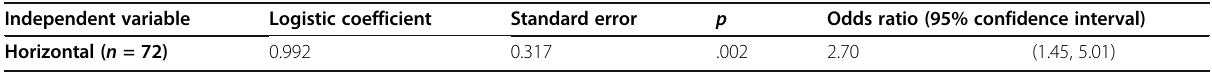
Table 6 Logistic regression models using horizontal distance for the unstable group a Independent variable